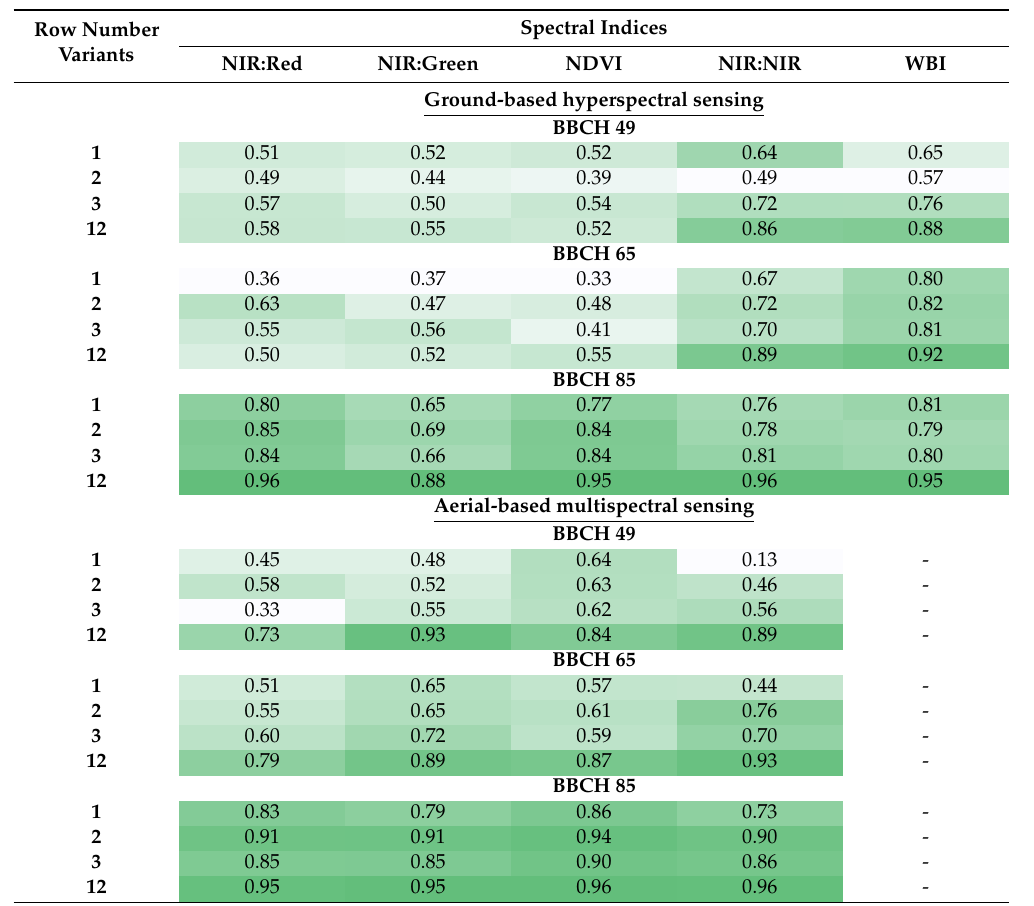
Table 5. Heritability of spectral indices from ground- and aerial-based sensing in plots with di ff erent row variants at BBCH scale stages 49, 65, and